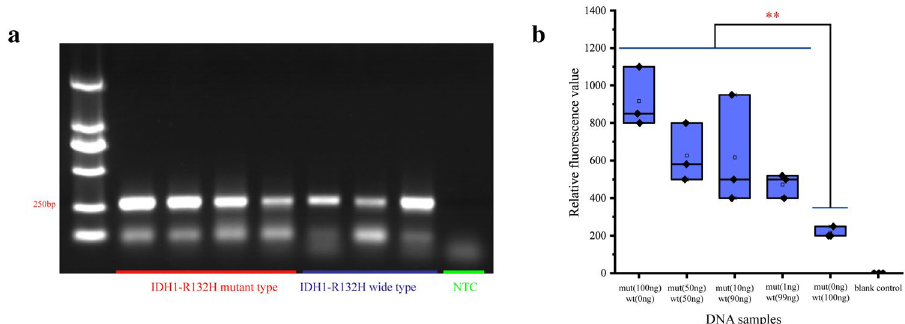
Figure 3. Validation of the Crispr-Cas12a fluorescence detection system. ( a ) Identification of the target gene amplification products by electrophoresis. The belts of IDH1-wt (the first four belts) and IDH1-R132H (the latter four belts) of electrophoresis with the length of 262 bp. ( b ) Verification of fluorescence system. Non- amplified IDH1-wt and IDH1-R132H were mixed in different proportions to simulate the IDH1-R132H at 100%, 50%, 50%, 10%, 1% and 0 frequencies in vivo, respectively. Using Crispr-Cas12a to perform the test for 3 times, the relative fluorescence value was positively correlated with the IDH mutation frequency range with qualitative detection power, and the lowest detectable mutation frequency was 1% theoretically (link: https:// www. adobe. com/ produ cts/ illus trator. html/, version 24.0.1).